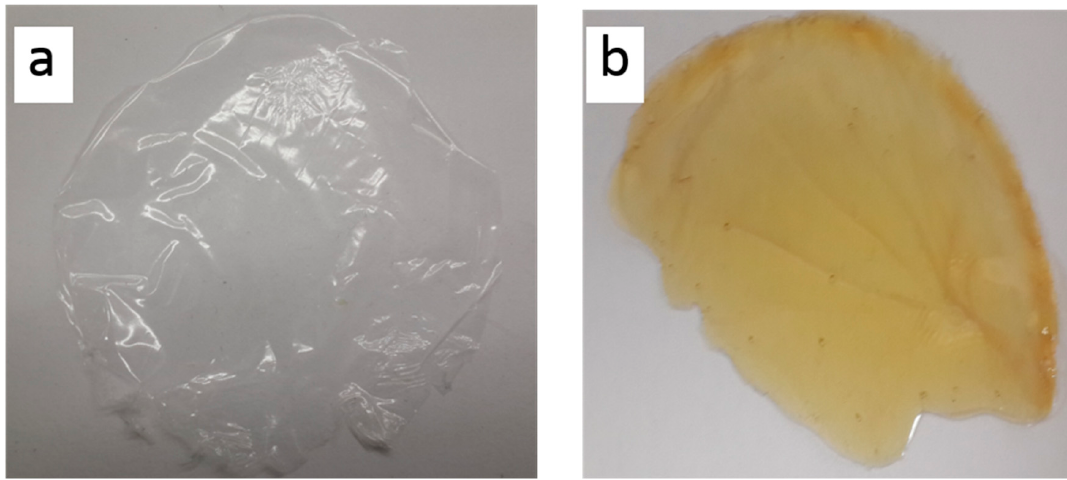
Figure 2. Images of PE and PLA films: ( a ) PLA; ( b ) PE. Table 3. Permeability values for PLA and PE